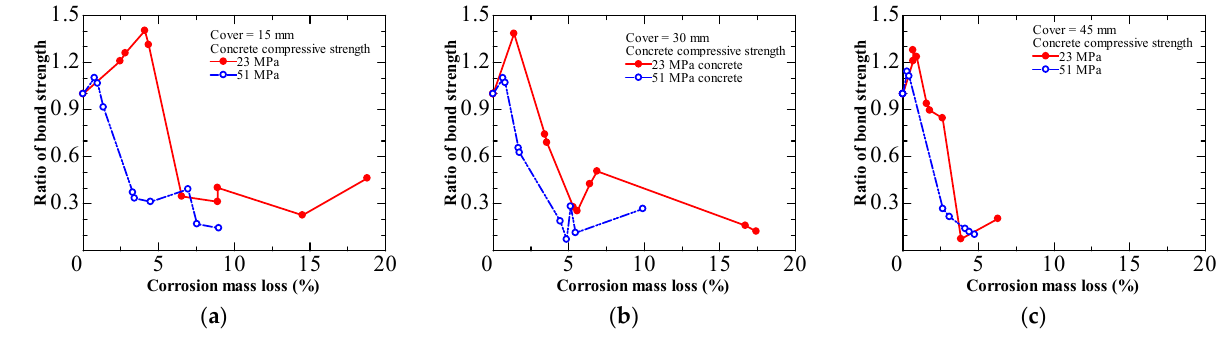
Figure 13. Influence of concrete strength on bond deterioration from Yalciner et al. [40]: ( a ) cover = 15 mm; ( b ) cover = 30 mm; ( c ) cover = 45 mm.